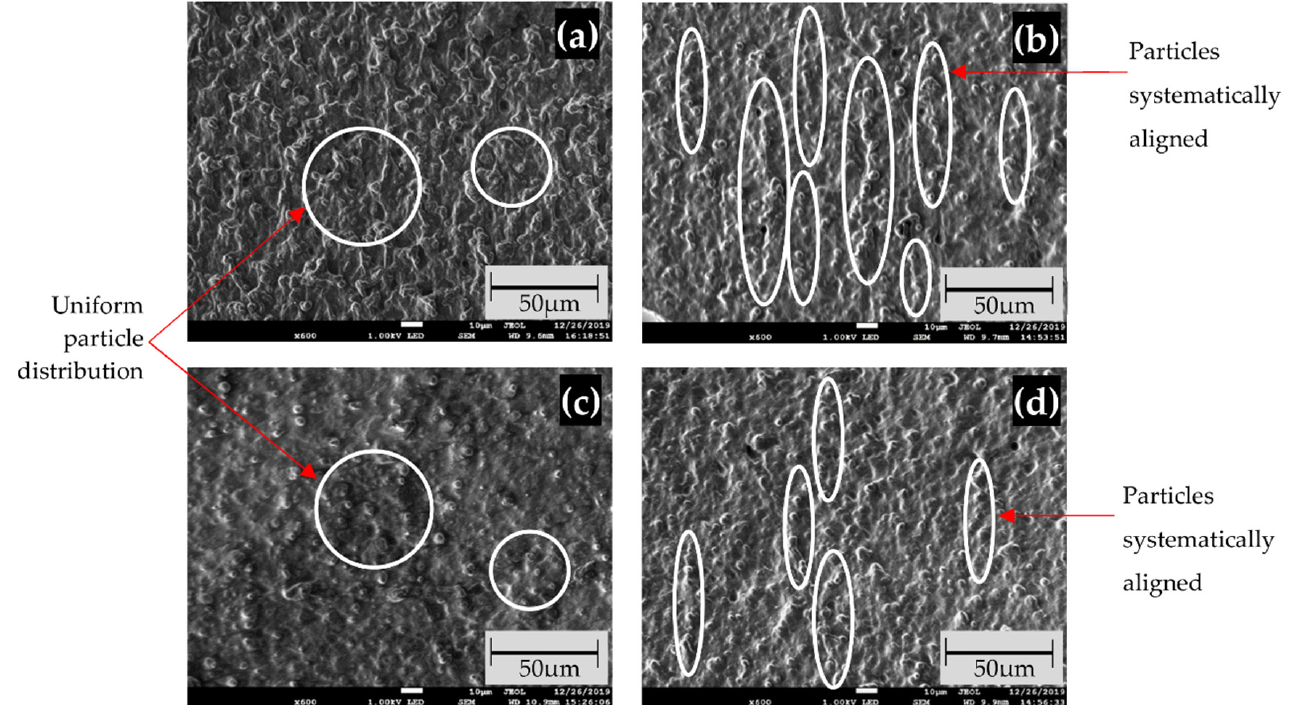
Figure 3. FESEM images at × 600 magnification of particle dispersion in ( a ) high wt% isotropic distribution; ( b ) high wt% anisotropic distribution; ( c ) low wt% isotropic distribution; and ( d ) low wt% anisotropic distribution. The inserted scale bar is 1:5 of FESEM original dimension.